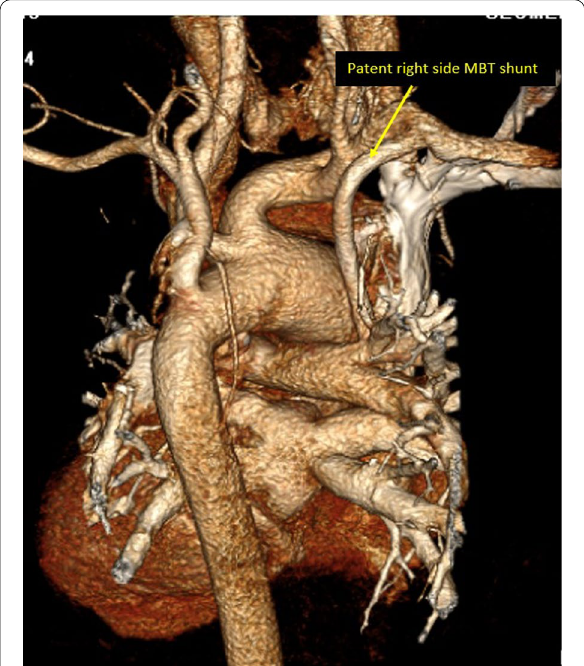
Fig. 7 3D volume rendering image showing patent right MBT shunt from the right subclavian artery to the right pulmonary